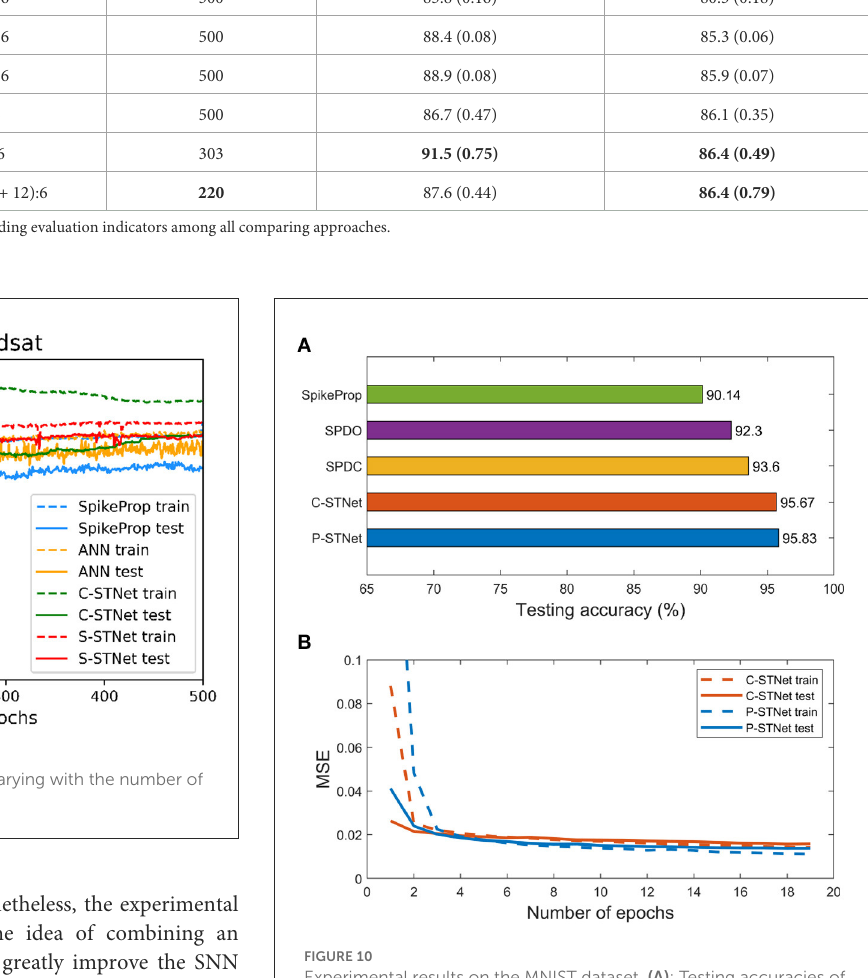
series and parallel combinations may produce different